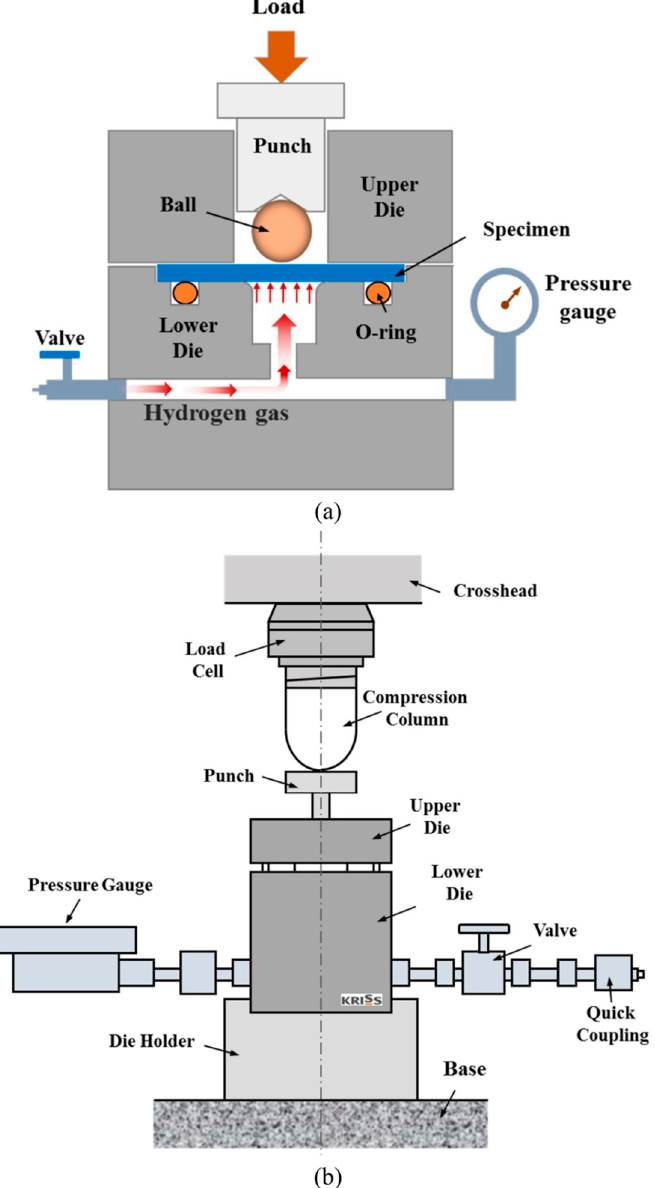
Figure 9. Schematic illustration of SP test with gaseous environments: ( a ) SP test jig, ( b ) test equipment [53].